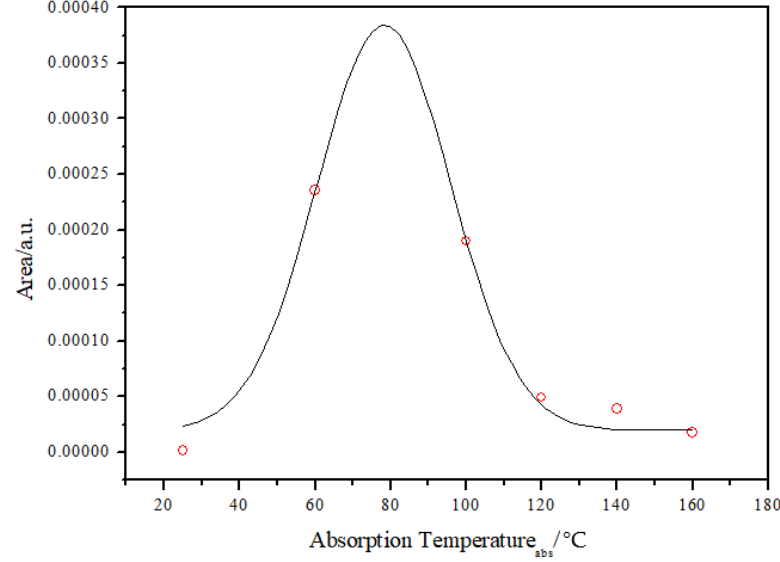
Figure 5. The total area of H 2 absorbed in Pd 79 –Ag 21 foil for different absorption temperatures.